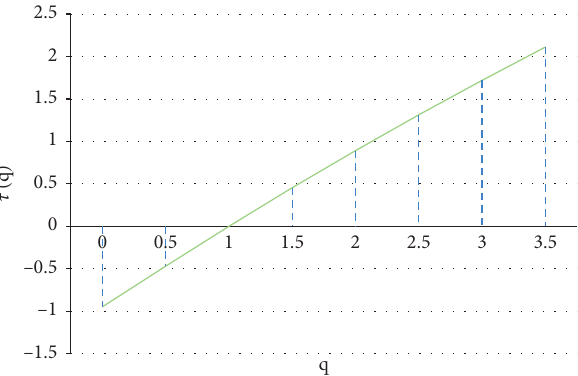
Figure 3: Relationship between network nonrumors τ ( q ) − q